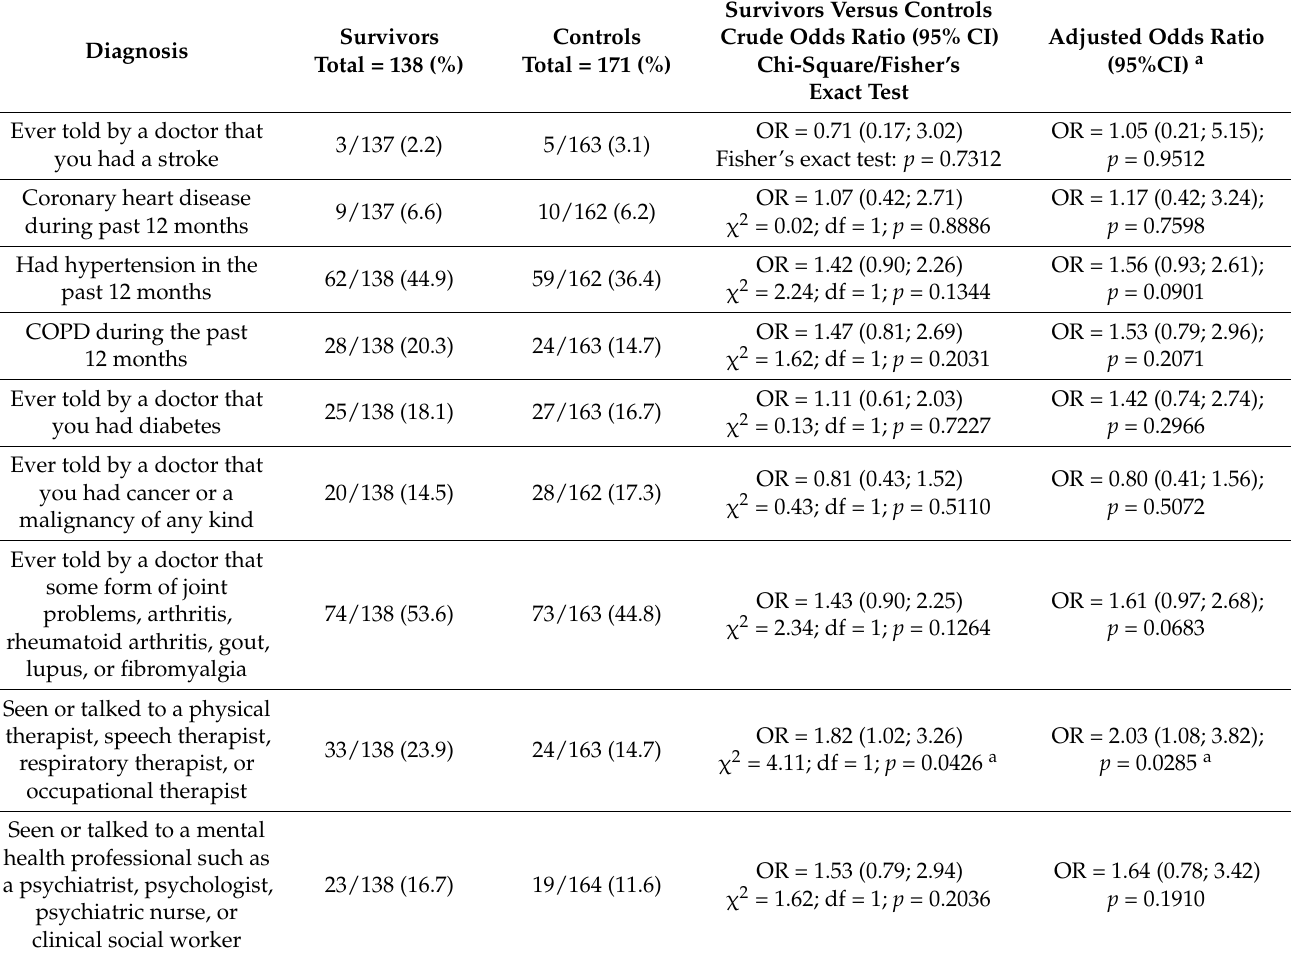
Table 2. Bivariate and multivariable analysis: Medical Diagnosis and Health Care